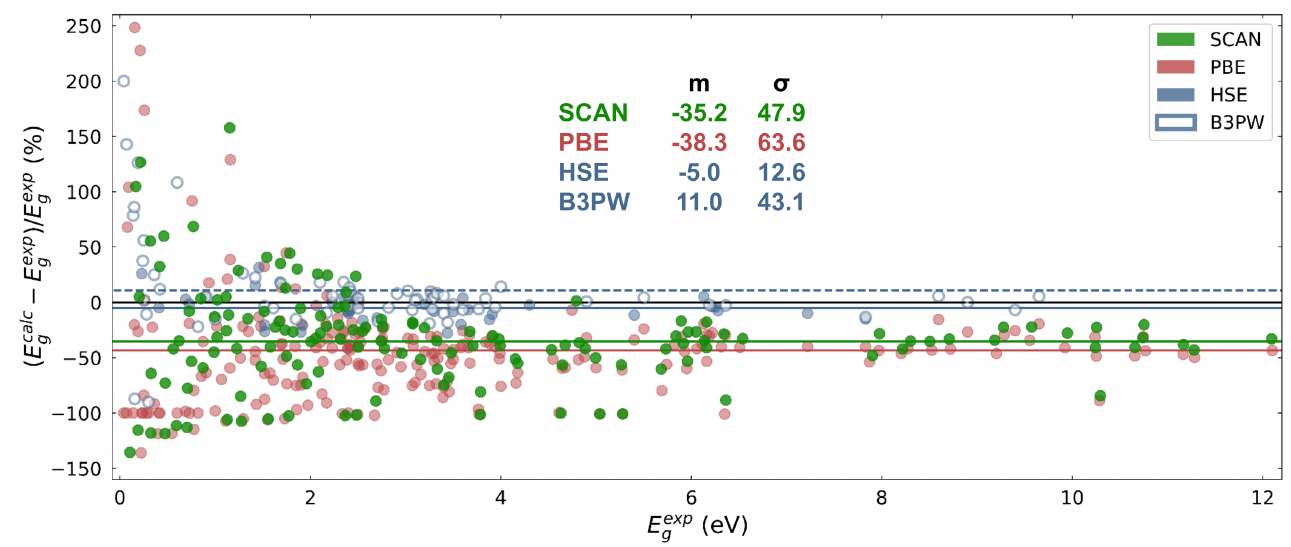
Figure 6. Comparison of the calculated and experimental band gaps for the binary compounds calculated with SCAN and PBE [46], HSE and PBE [16,67], and B3PW and PBE [69], containing the main group elements and TM ions. The experimental values are shown as the zero black